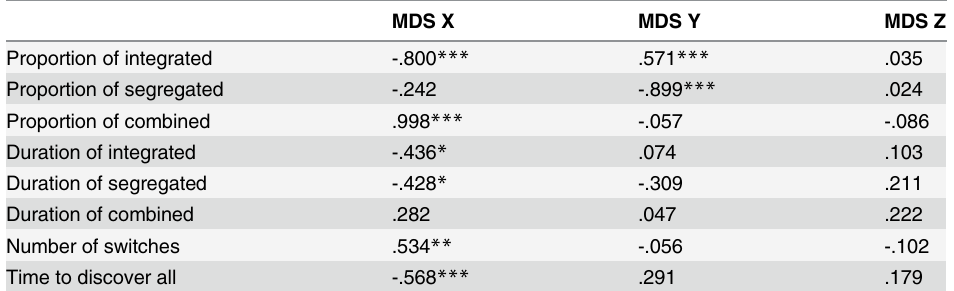
Table 2. Spearman ’ s Rank Order correlation coefficients between the Multi-Dimensional Scaling dimensions and the perceptual variables. MDS X MDS Y MDS Z Proportion of integrated -.800 *** .571 *** .035 Proportion of segregated -.242 -.899 *** .024 Proportion of combined .998 *** -.057 -.086 Duration of integrated -.436 * .074 .103 Duration of segregated -.428 * -.309 .211 Duration of combined .282 .047 .222 Number of switches .534 ** -.056 -.102 Time to discover all -.568 *** .291 .179 MDS X = the fi rst dimension of the MDS, MDS Y = the second dimension of the MDS, MDS Z = the